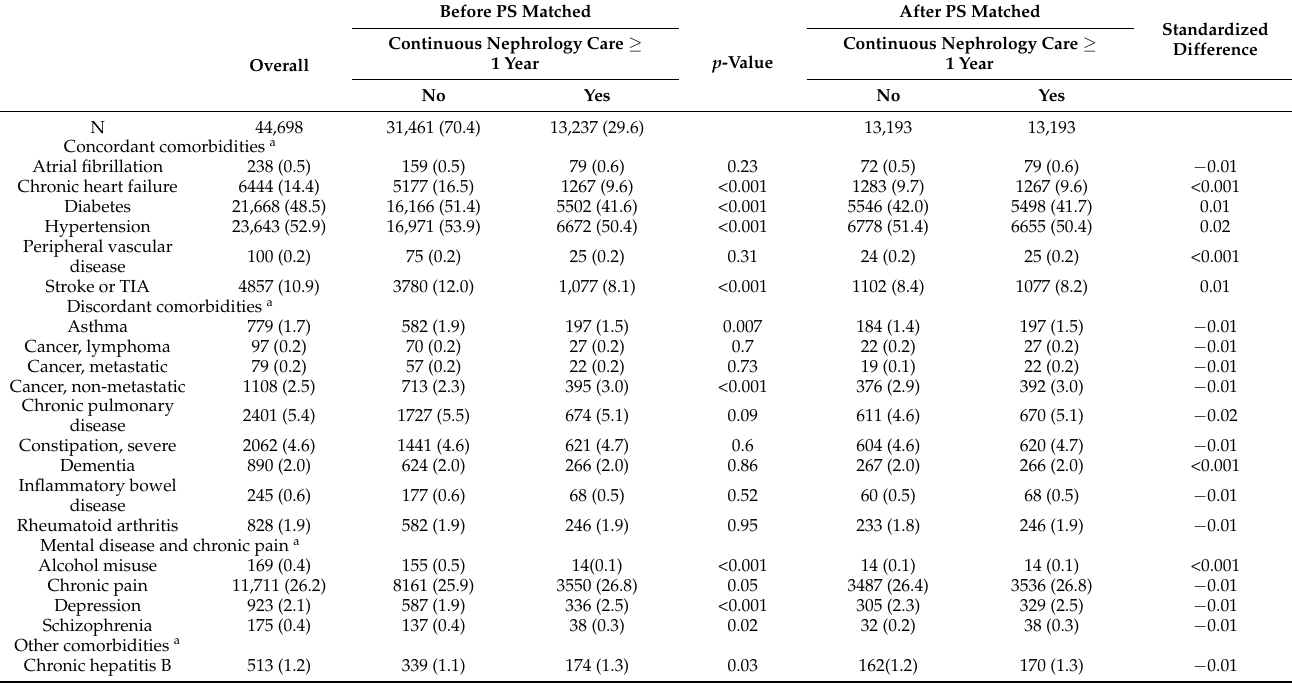
Table 2. Prevalence of comorbidity by the duration of nephrology